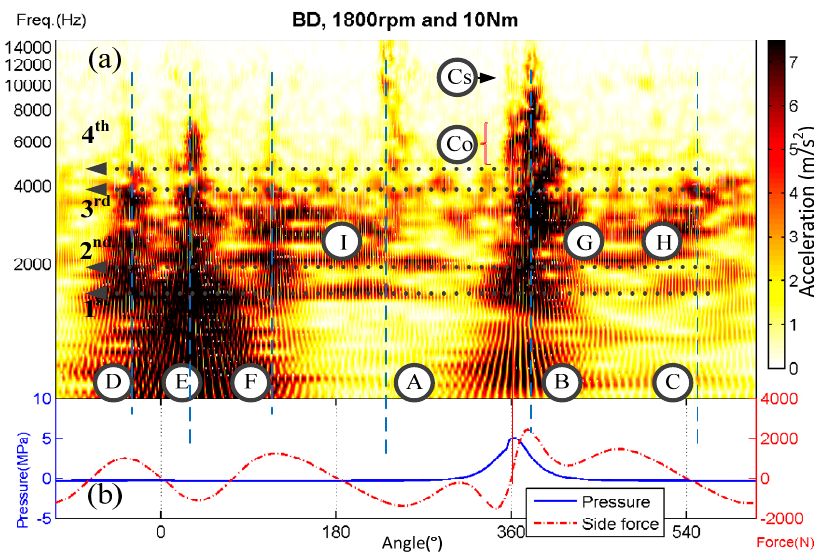
Figure 22. Continuous wavelet transform (CWT) of vibration signal fueled with biodiesel under 10 Nm and 1800 rpm; ( a ) CWT result of measured acceleration response; ( b ) Measured in-cylinder pressure and calculated piston side-thrust force.